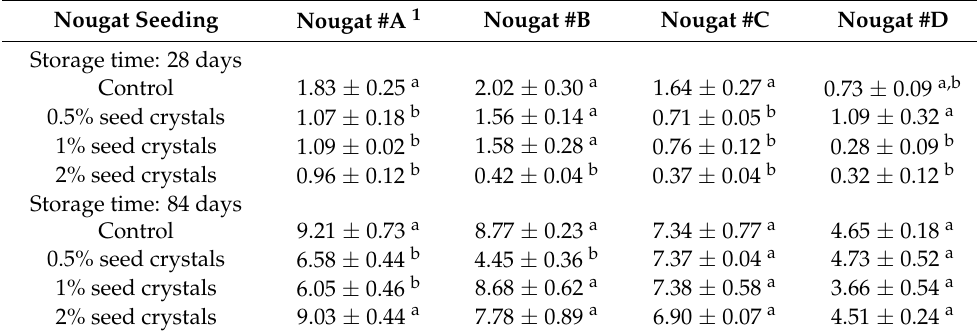
Table 3. Effects of crystal seeding on specific enthalpies (J/g) of the nut oil melting peak in the chocolate on top of nougat layers after 28 or 84 days of storage at 23 ◦ C. Mean values with different superscripts in a column indicate statistical differences ( p < 0.05).